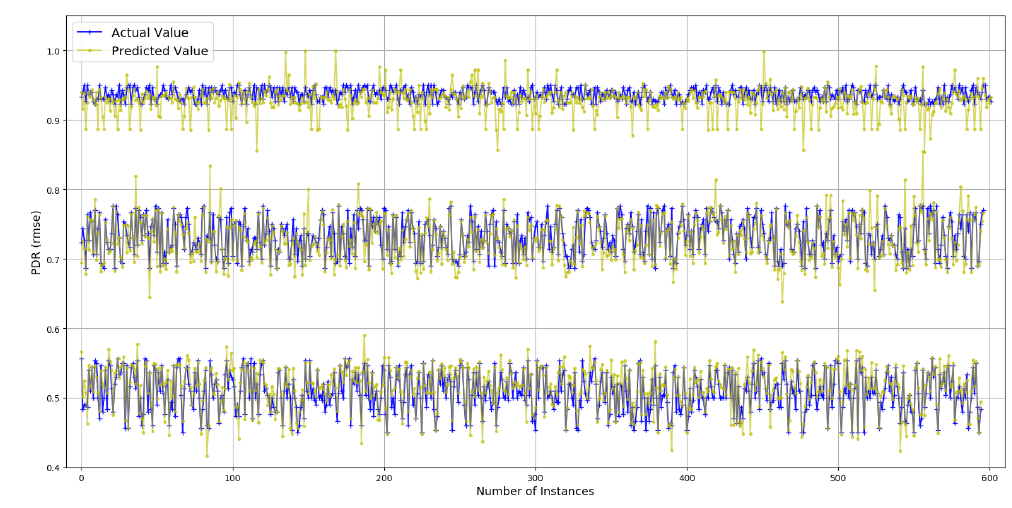
Figure 5. Actual values vs. predictions for PDR (selected